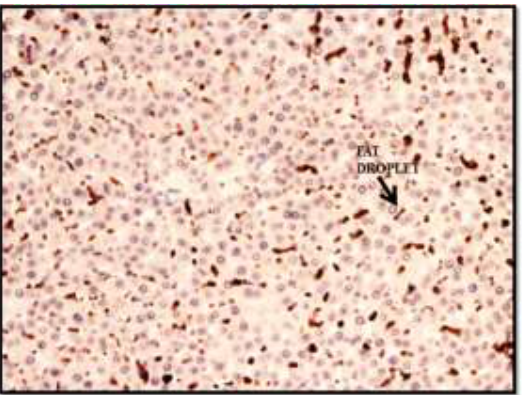
Figure 5a: Photomicrograph of H&E stained 4 µm thick liver section showing Fat droplets (vacuoles) in rat hepatocytes on high-fat diet + Ginseng 100mg/kg (group 3) at ×400.